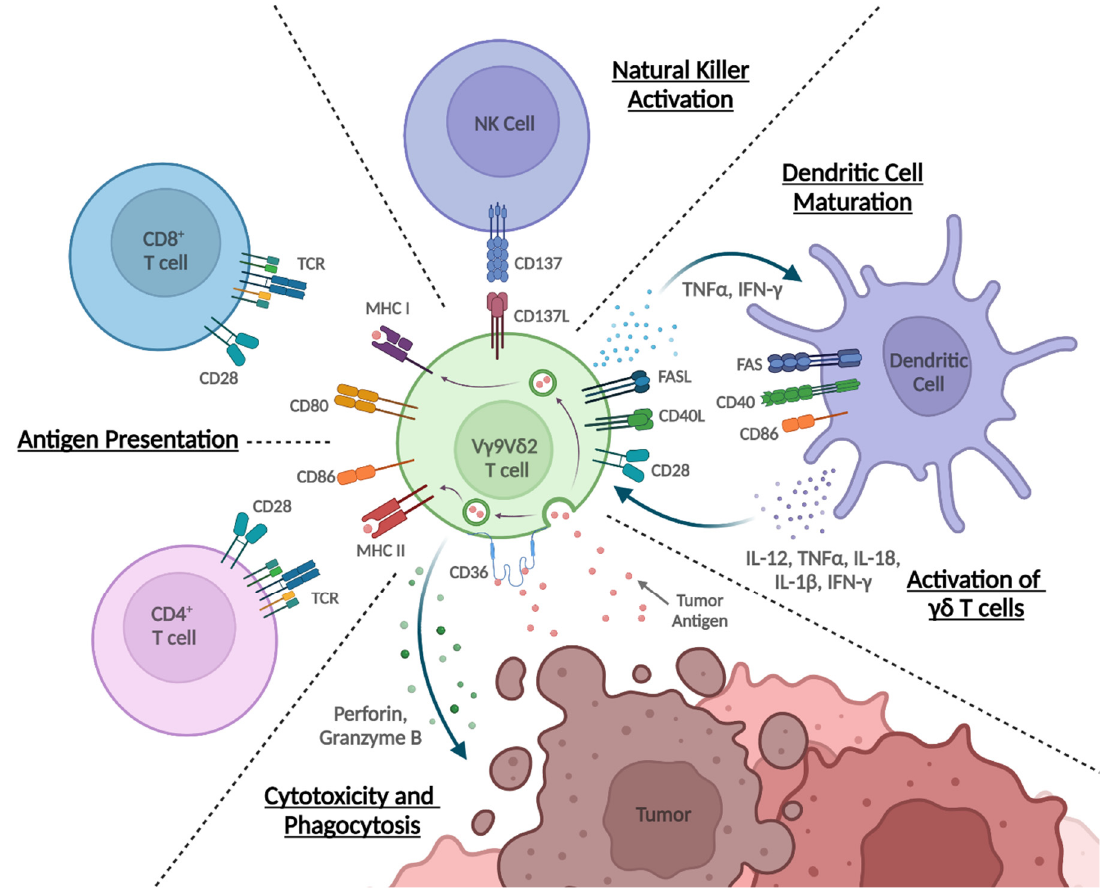
Figure 2. Regulation of antitumor immunity by V γ 9V δ 2 T cells. V γ 9V δ 2 T cells perform diverse immunological functions through interactions with other cells. They are directly cytotoxic to tumor cells through multiple mechanisms including perforin and granzyme B production, and express CD36 to facilitate tumor antigen phagocytosis. Upon incorporating antigens, V γ 9V δ 2 T cells act as antigen presenting cells (APCs) and both directly and cross present antigens on MHC molecules to αβ T cells. Combined with expression of the co-stimulatory molecules CD80 and CD86, V γ 9V δ 2 T cells effectively induce αβ T cells to differentiate and proliferate. CD137L expressed on V γ 9V δ 2 T cells activates NK cells by engaging CD137, increasing their NKG2D expression, direct cytotoxicity,